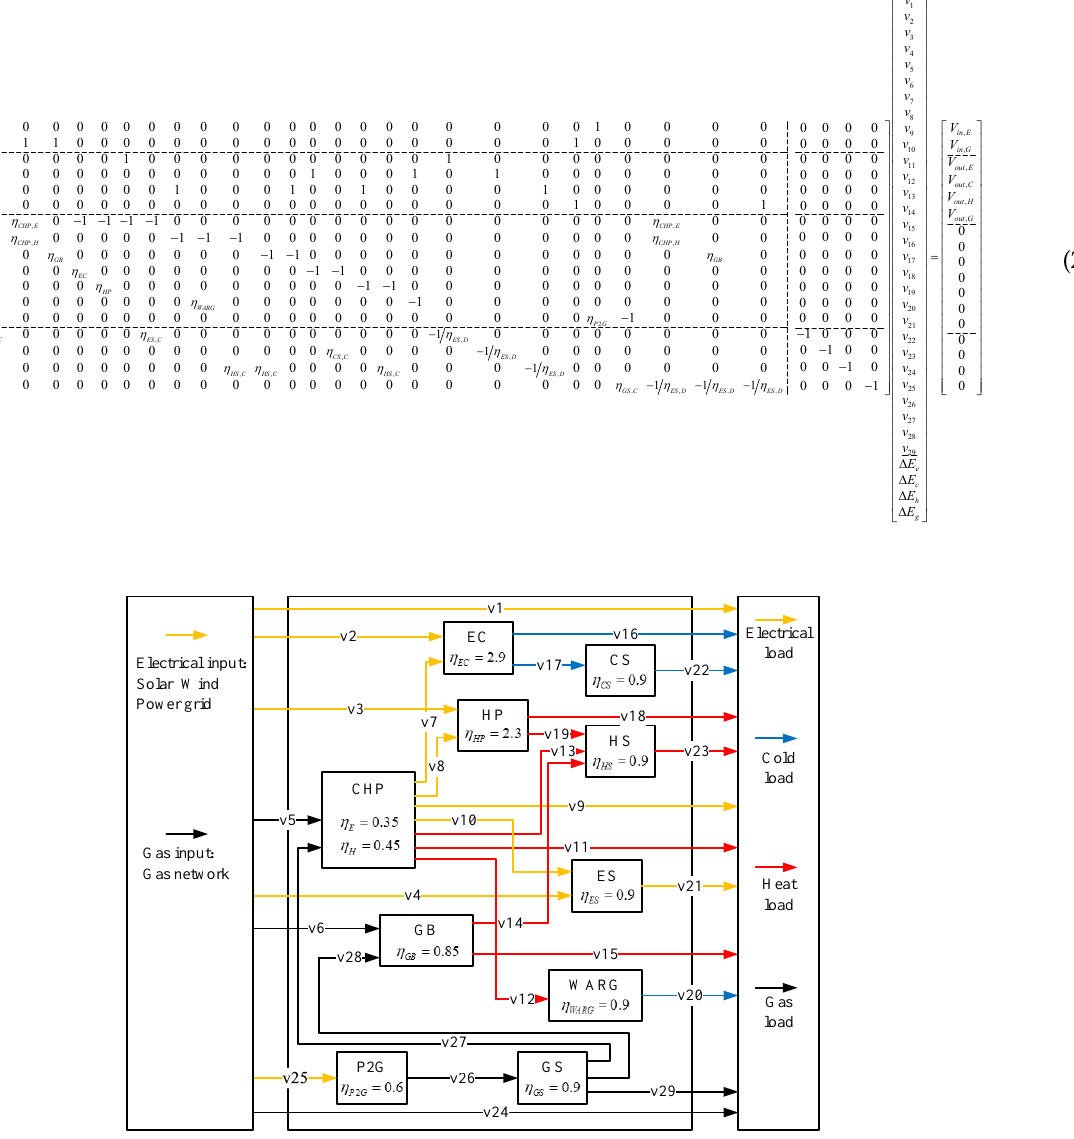
Figure 2. PIES 1 structure with P2G equipment.